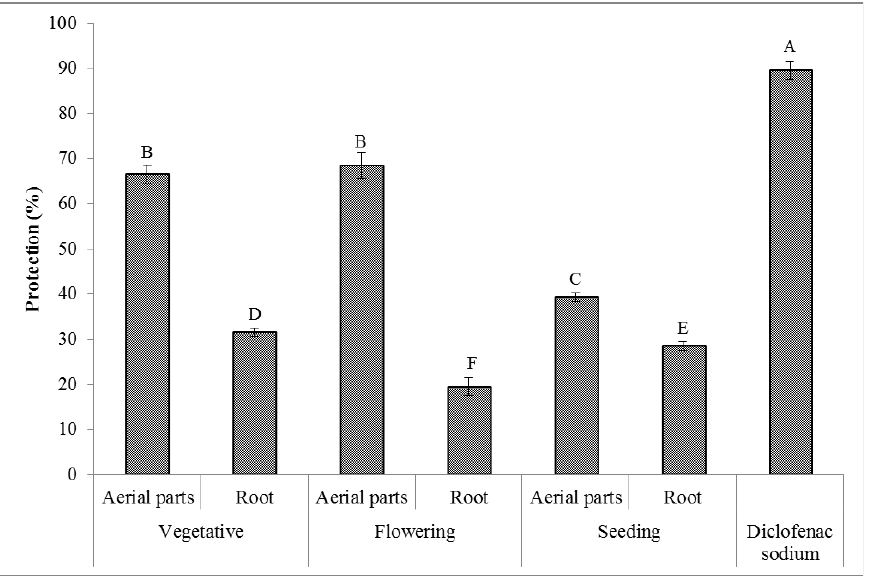
Figure 7. The anti-inflammatory activity ( n = 3) of the extracts of the T. polium aerial parts and root at different phenological stages. The extract concentration is 200 µg/mL. Various letters indicate statistically significant differences ( p < 0.05).